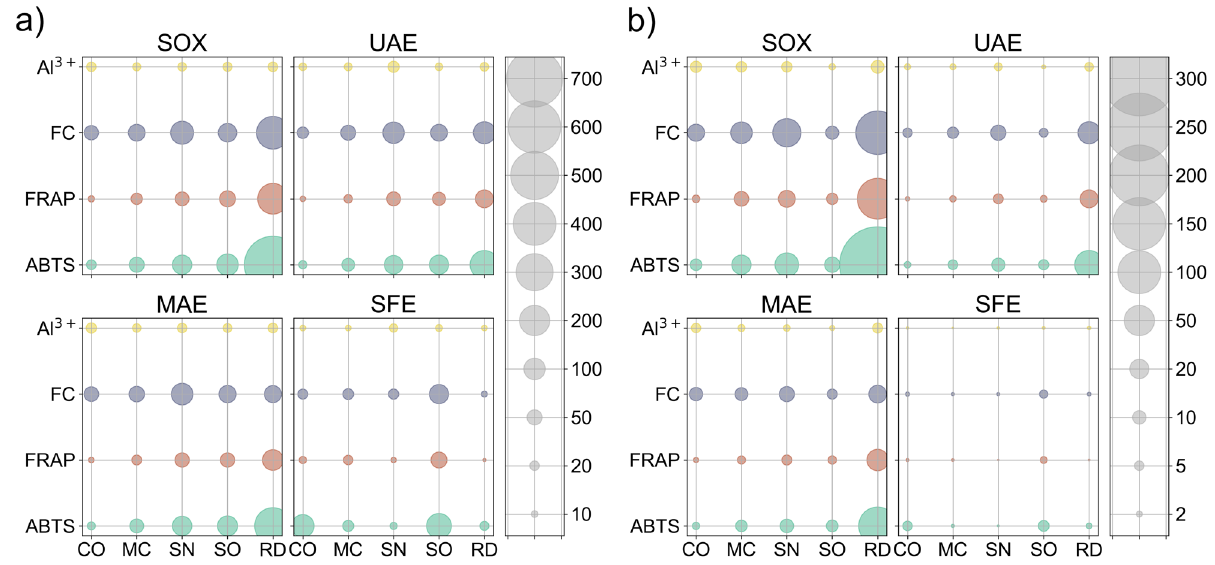
Figure 2. Comparison of activities of different extracts in all colorimetric assays, shown as milligram- equivalents of appropriate standard per gram of ( a ) pure extract or ( b ) raw plant material (see “Materials and methods” and Supplementary material for details). Error bars are omitted for clarity. All results (triplicate for each extract) were within ± 5% of each